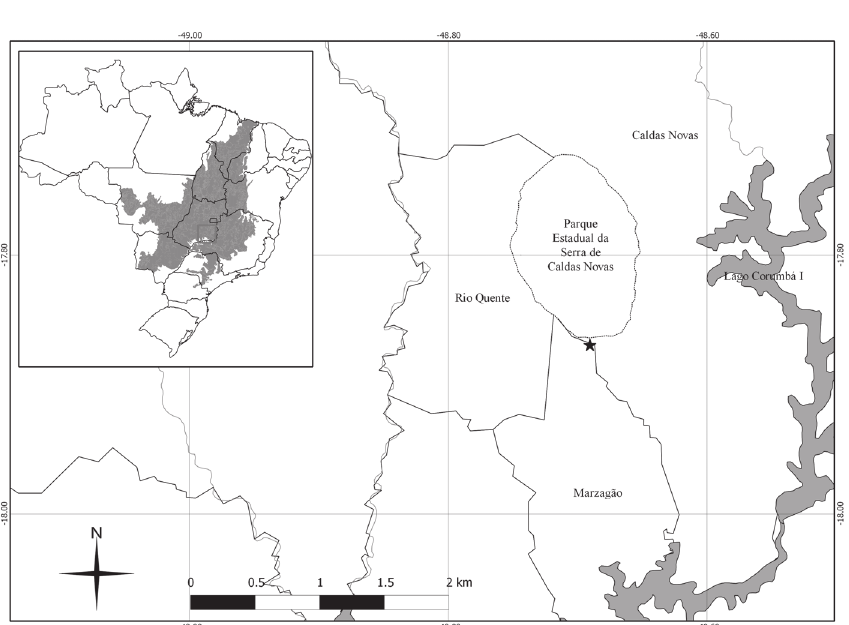
Figure 1. Geographic localization of the artificial pond used as breeding sites by Pseudis bolbodactyla , Municipality of Caldas Novas, Goiás, Brazil.